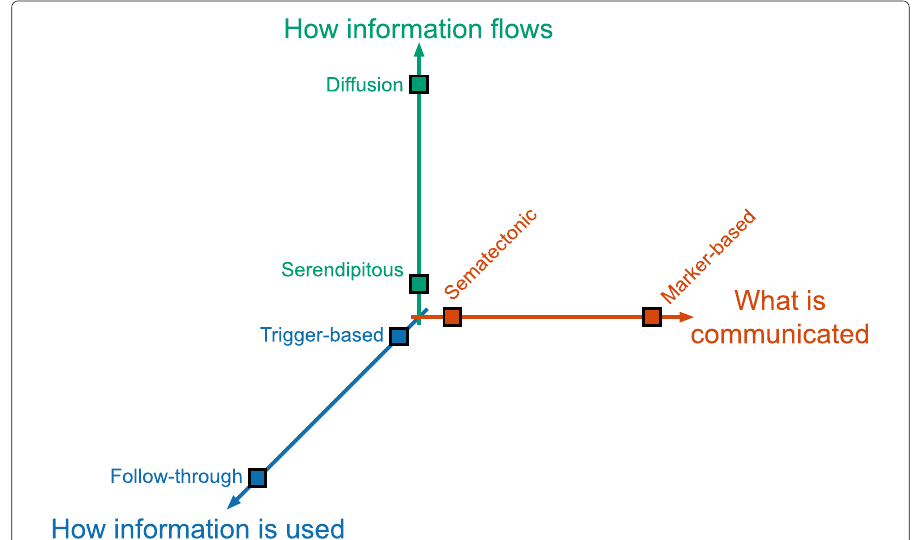
Fig. 2 Three dimensions of information processing define the self-organized mechanism in a swarm system: how information flows, how information is used, and the definition of information. The diffusion flow occurs when individuals passively receive information that other individuals spread in the environment whereas serendipitous flow occurs when individuals need to actively search for information left in the environment by other individuals. When using information in a trigger-based system, individuals act in the environment by performing specific, mostly one-off, actions, while in a follow-through , they are guided by what they find, and the action can be more long-lasting. The marker-based information is explicitly defined for interaction purposes (e.g., pheromone), while individuals implicitly share sematectonic information as the current state of the population (figure adapted from (Mamei et al.